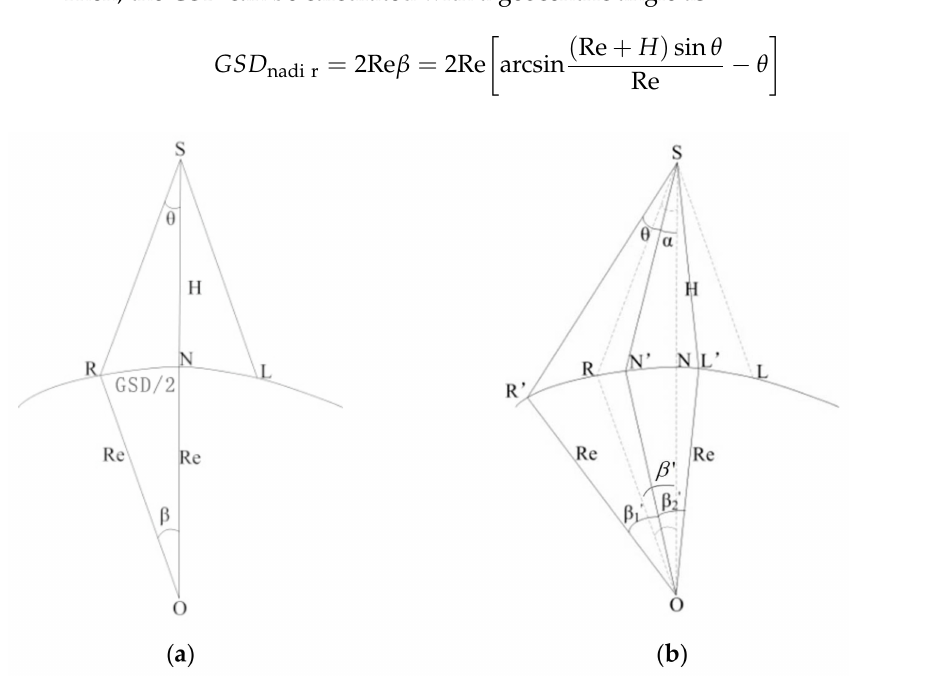
Figure 2. The schematic diagram of the GSD. ( a ) the nadir point; ( b ) off the nadir point. According to Formula (2) and the designed IFOV value, the GSD is 48.62 m at the nadir point, an outcome which is better than the released spatial